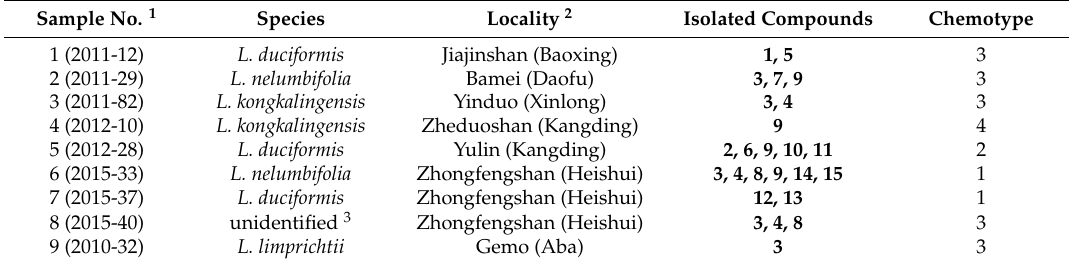
Table 1. Collection locality and chemical composition of L. duciformis , L. kongkalingensis , L. nelumbifolia , and L. limprichtii